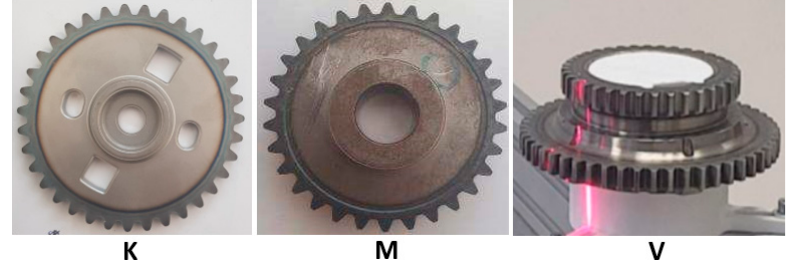
Figure 1. Illustration of various gear wheels (types “K”, “M”, and “V”) as objects of inspection.